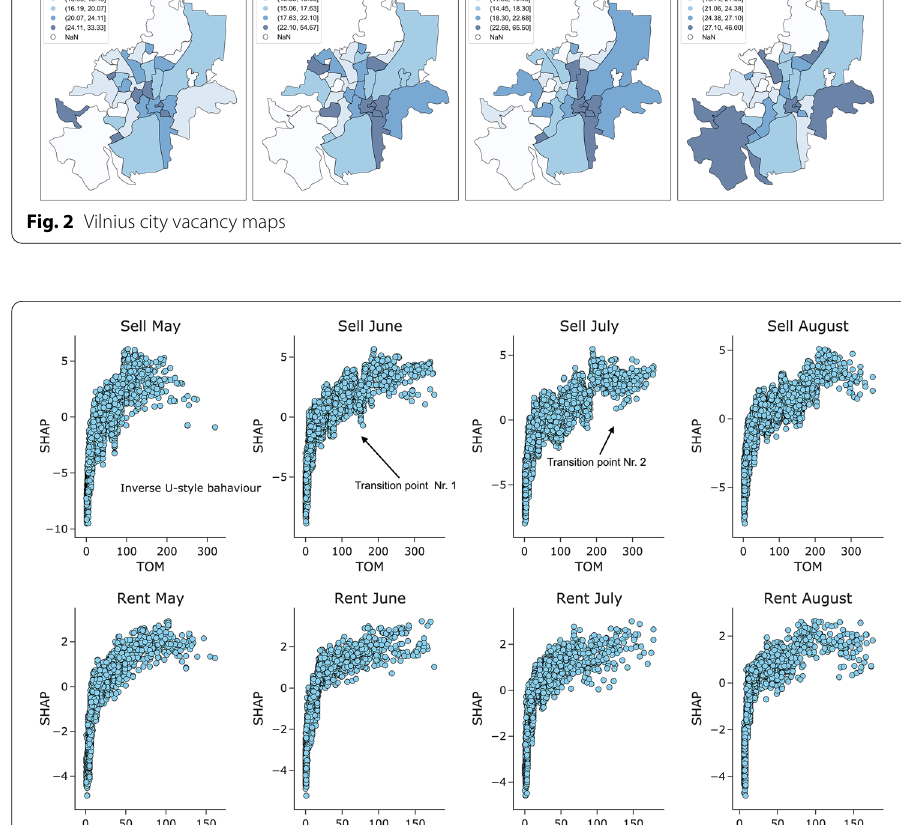
Fig. 3 The TOM variable